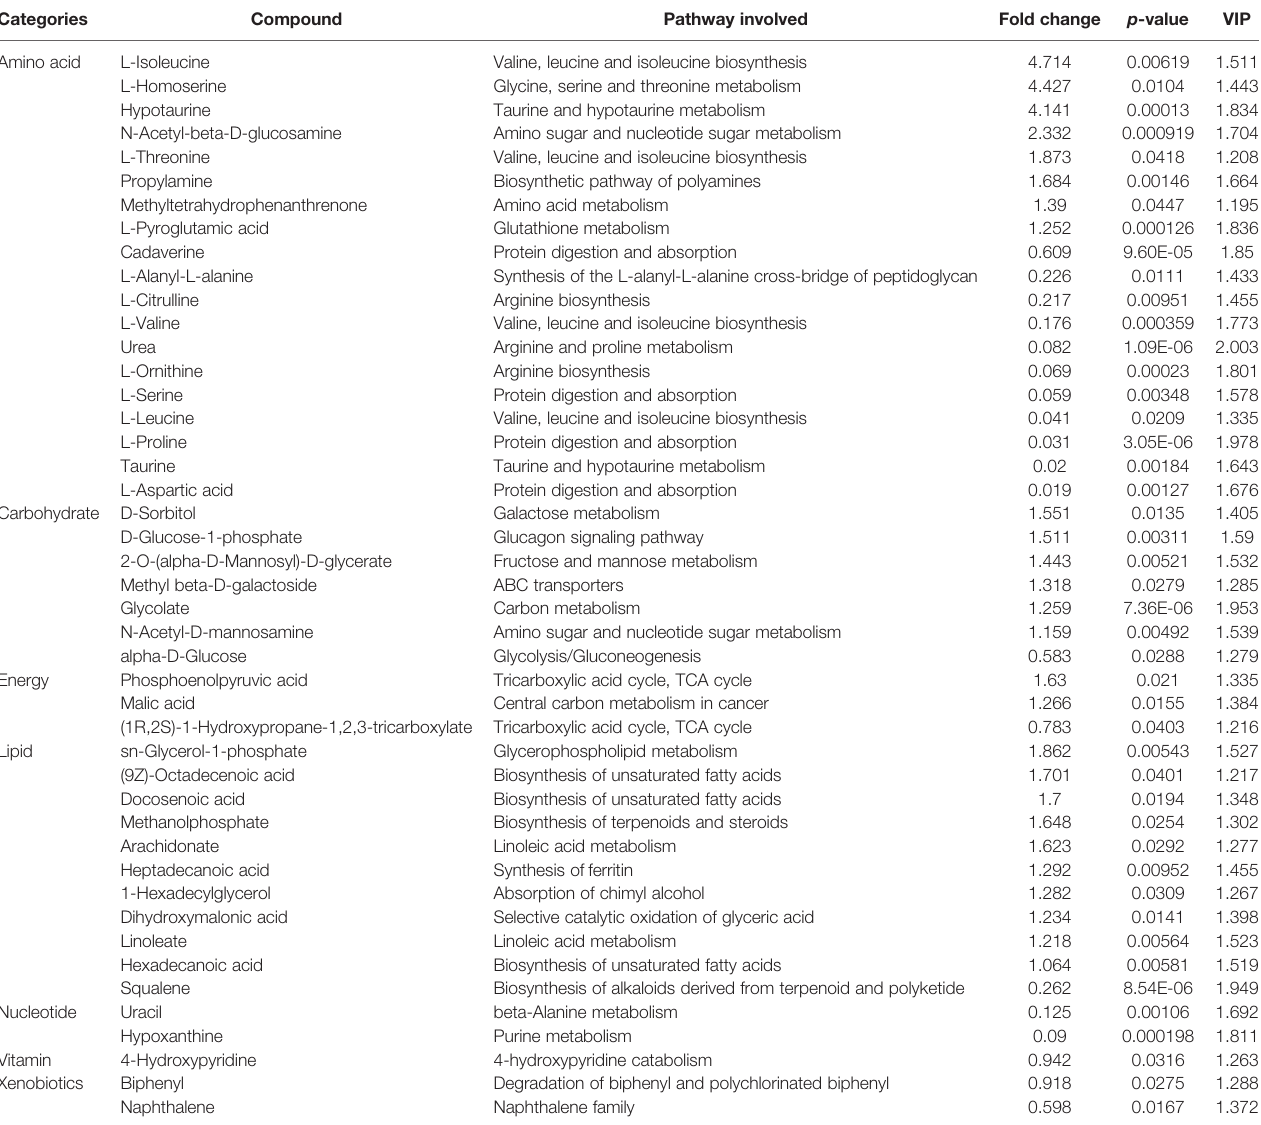
TABLE 2 | Signi fi cantly changed differential metabolites in EU vs. CP